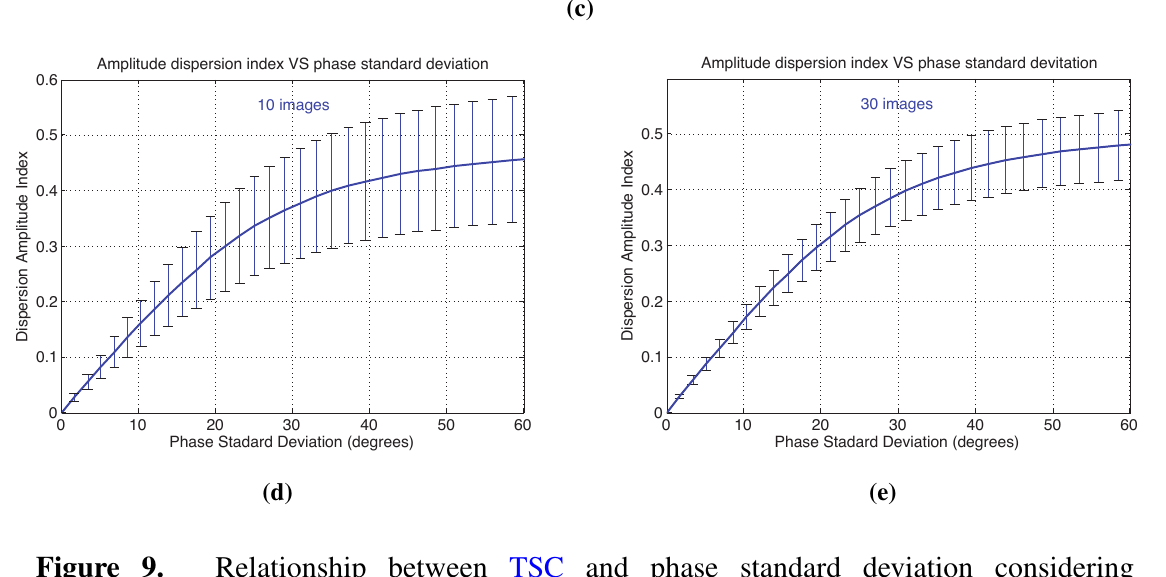
Figure 9. Relationship between TSC and phase standard deviation considering ( a ) 10 and ( b ) 30 SAR images; ( c ) phase standard deviation as a function of coherence for different numbers of multi-look (ML) factors; comparison of the amplitude dispersion index D and the phase standard deviation (in A degrees) as a function of noise computed by numerical simulation considering ( d ) 10 and ( e ) 30 SAR images